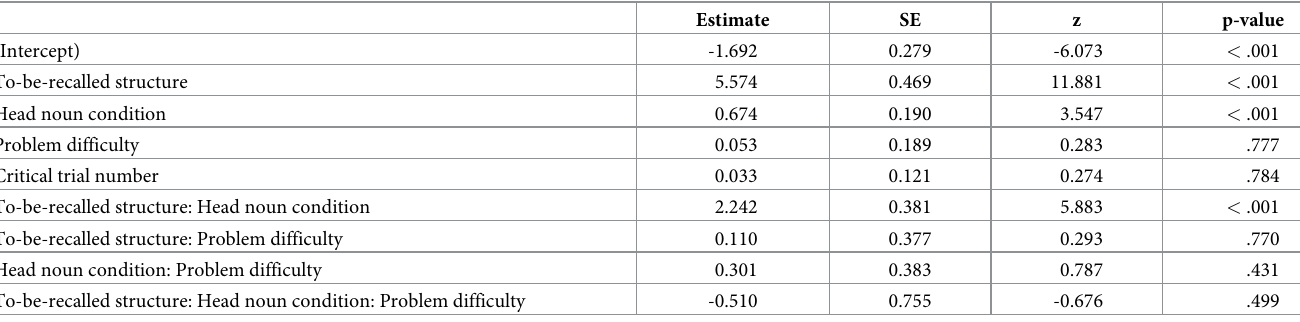
Table 3. Fixed effect estimates (in log odds units), Experiment